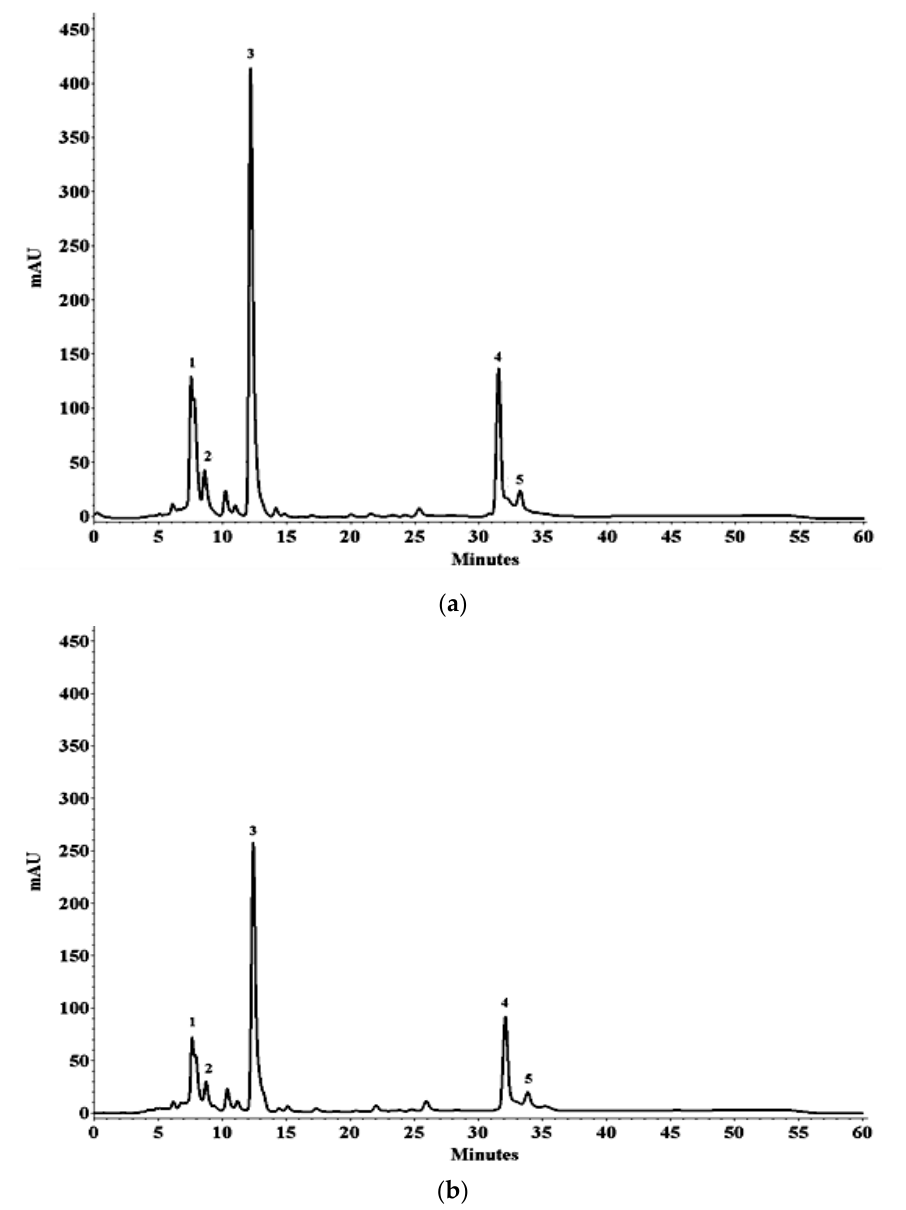
Figure 2. Chromatogram obtained by HPLC-DAD of carotenoid extracts of Jambu leaves dried by freeze-drier ( a ) and in an oven at 35 °C ( b ). Peak characterization (1, 2, 3, 4 and 5) is given in Table 4.